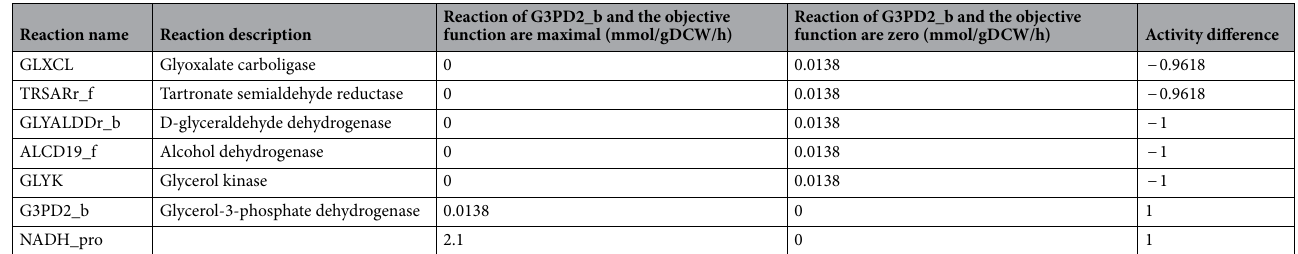
Table 1. Comparison of reaction rates for generating glycerol 3-phosphate. The suffixes _f and _b indicate the forward and backward directions of a reaction, respectively. The fluxes are presented in the unit of mmol/